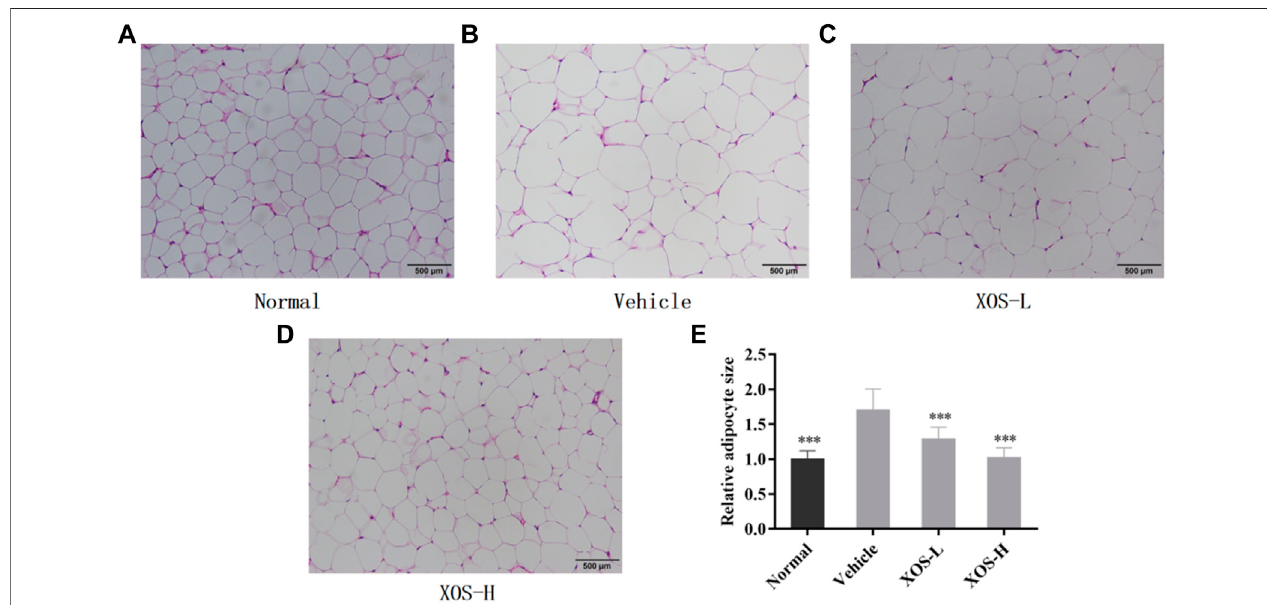
FIGURE 5 | (A – D) Effect of XOS supplementation on H&E pathological observation of epididymal fat in mice; (E) Relative adipocyte size. Magni fi cation 100 × . Normal: XOS-L: mice treat with XOS 250 mg/kg, XOS-H: mice treat with XOS 500 mg/kg. *** p < 0.001 compared with the Vehicle